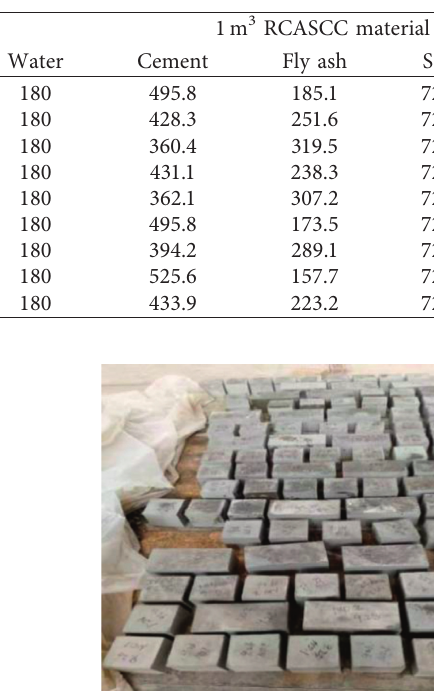
Table 8: Orthogonal test mix design and material dosage of each group.